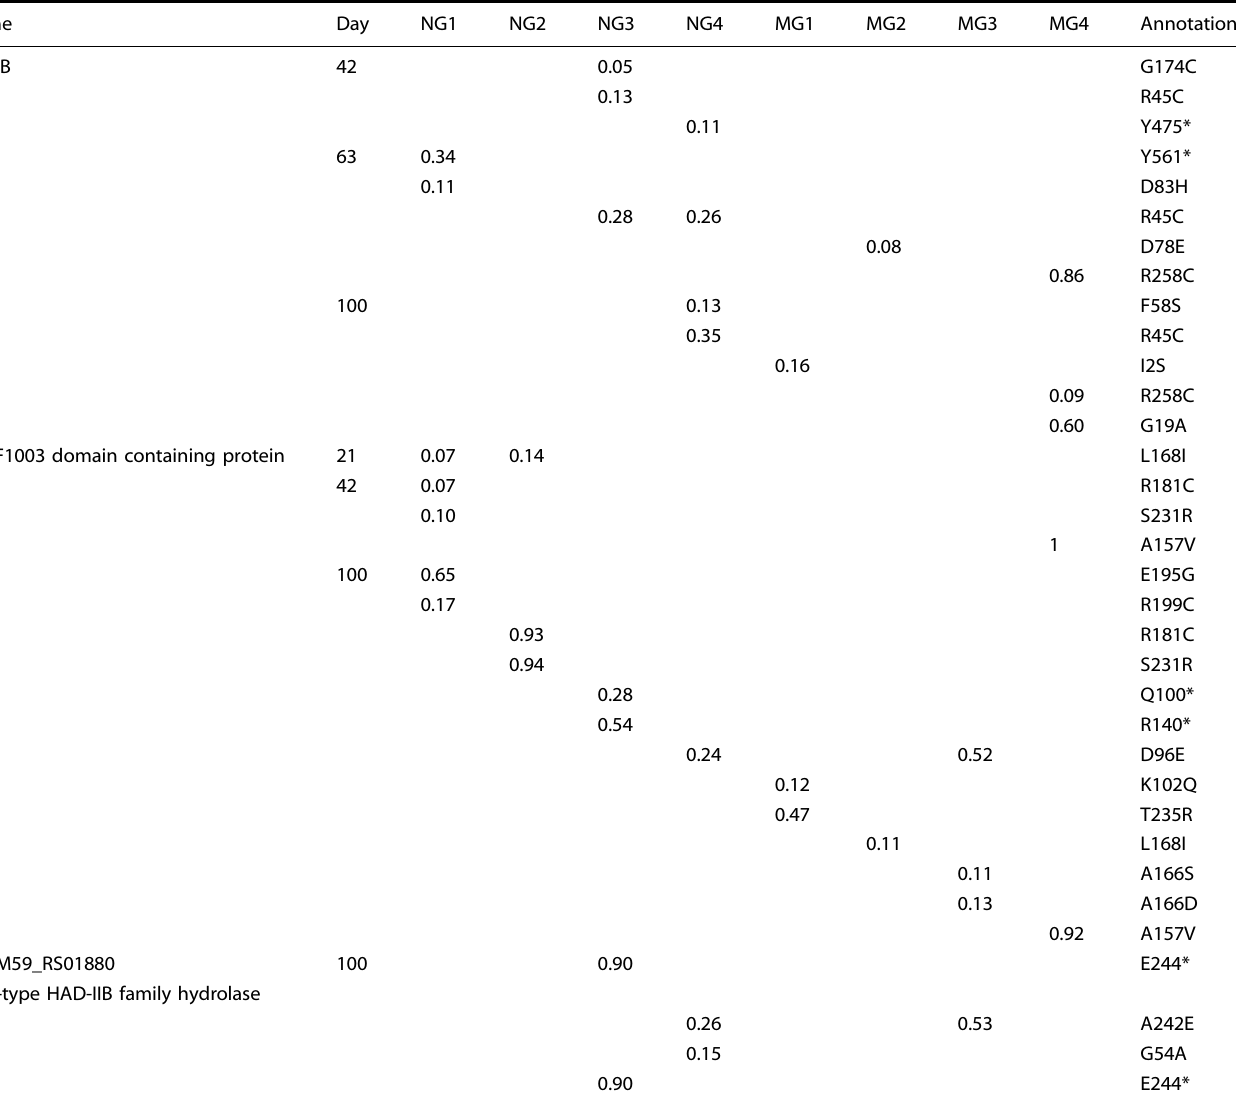
Table 2. Frequency of mutations detected earlier in normal gravity